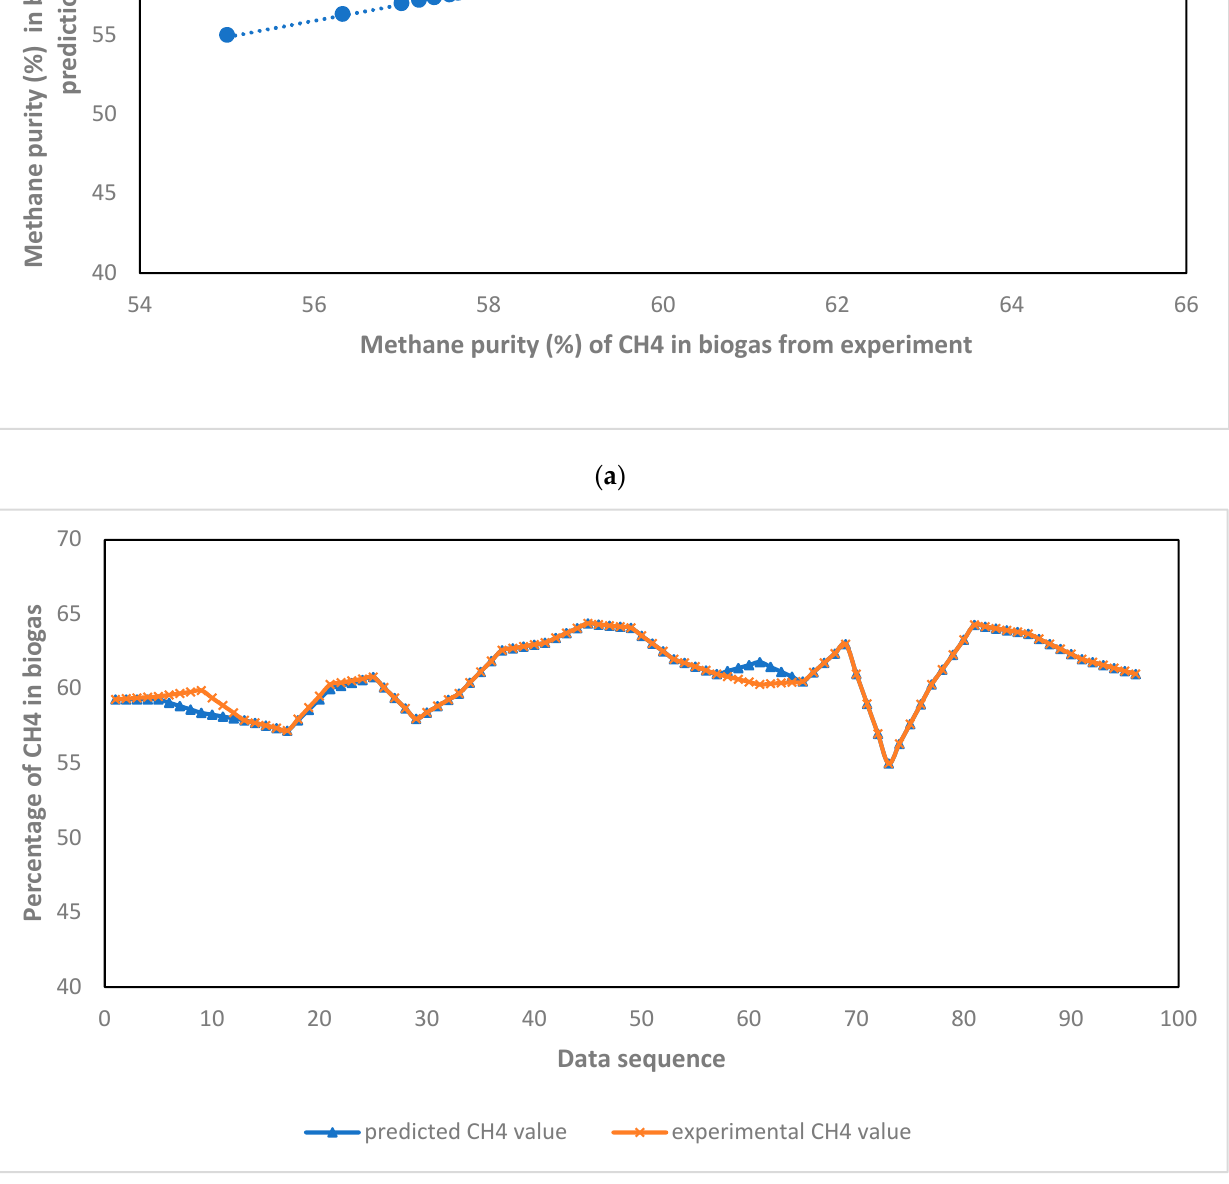
predicted CH4 value experimental CH4 value